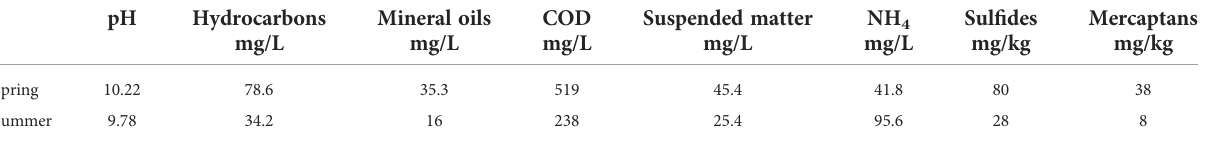
TABLE 2 Auxiliary ORWW parameters for two sampling